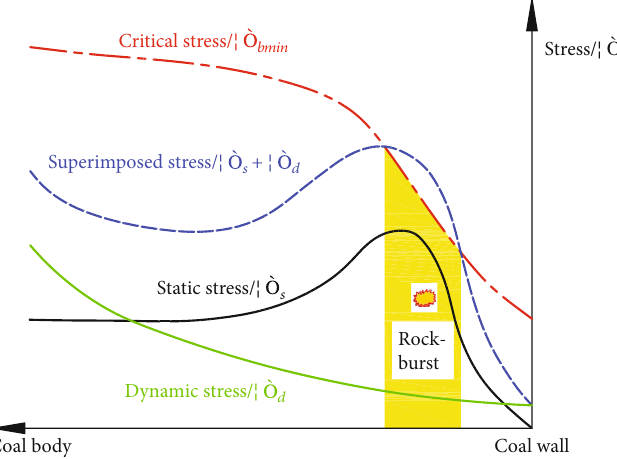
Figure 1: Superimposed stress of static and dynamic stress-inducing rock